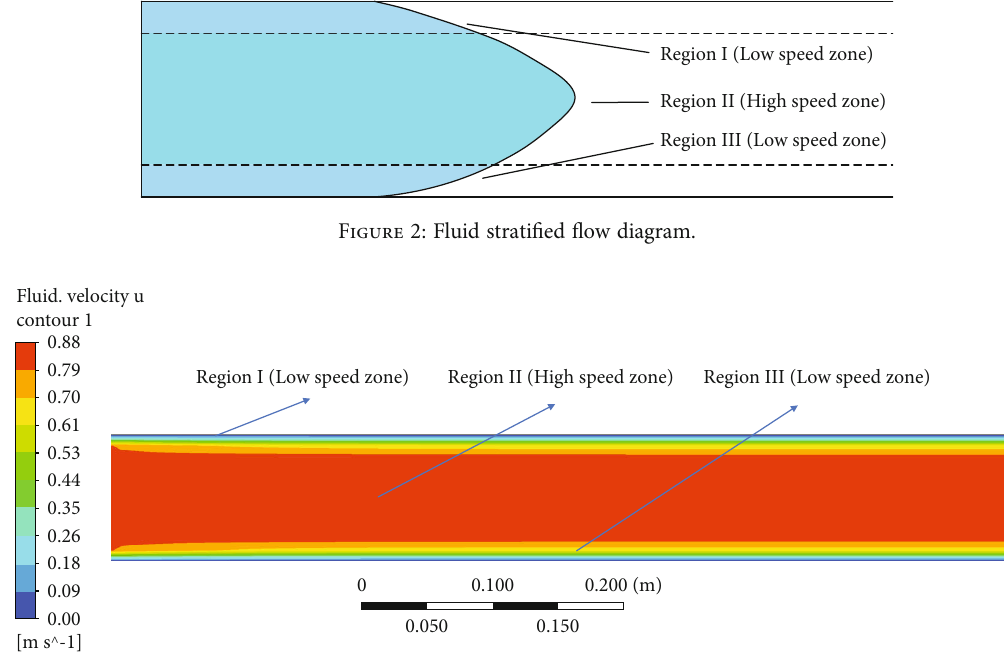
Figure 3: Cloud chart of fl uid velocity in single fracture fl ow fi eld (FLUENT).